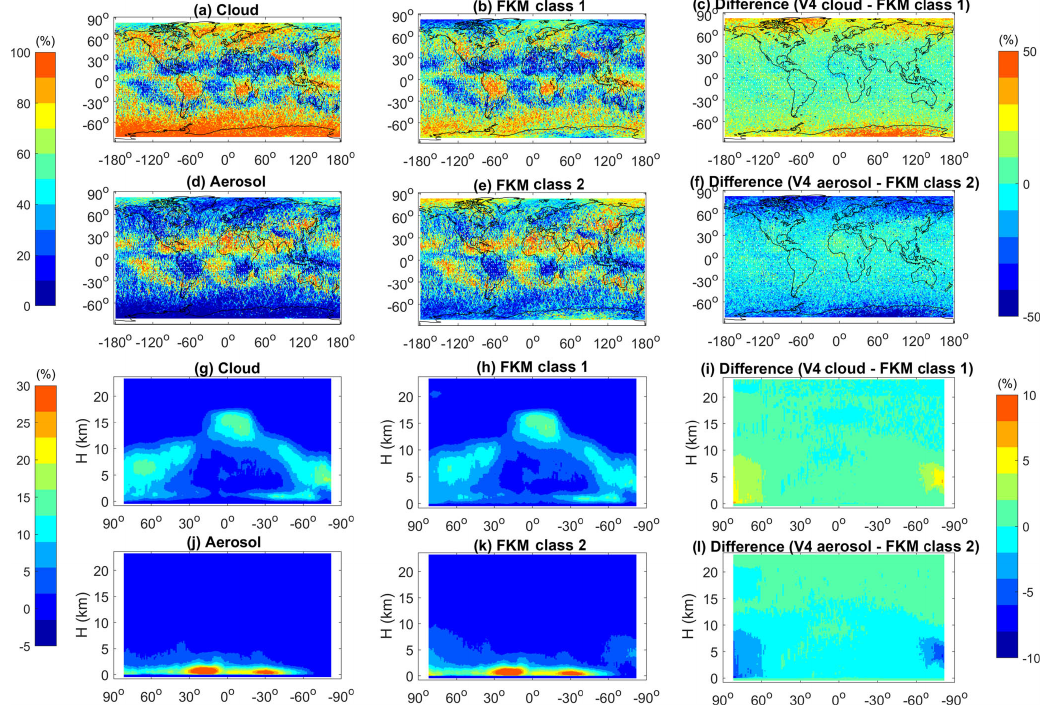
Figure 7. Distributions of feature type occurrence frequencies during January 2008. Panels in the left column show V4 COCA results; panels in the center column show CAD FKM two-class results; and the panels in the right column show the percentages of differences between the left and center columns. The top two rows show maps of occurrence frequencies as a function of latitude and longitude for clouds (a–c) and aerosols (d–f) . The bottom two rows show the zonal mean occurrence frequencies of clouds (g–i) and aerosols (j–l)